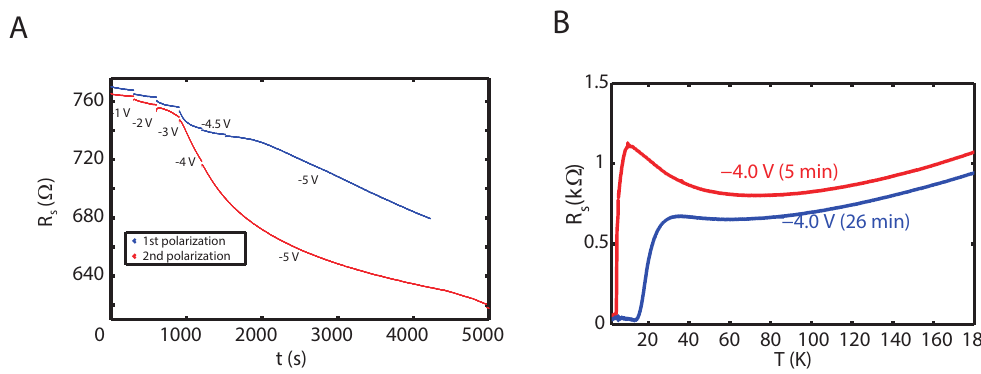
Figure 3. ( A ) Evolution of the sheet resistance R S of a 30 UC La (LaAlO ) (Sr AlTaO ) as a function of time, while the gate voltage is switched to increasing 3 0.3 2 6 0.7 negative values at the points indicated; ( B ) Temperature dependence of the sheet resistance R S for different polarization times and for the first and second polarization at V g = − 4 V. The midpoint T c increases from 5 K to 17 K for polarization times of 5 and 26 min,